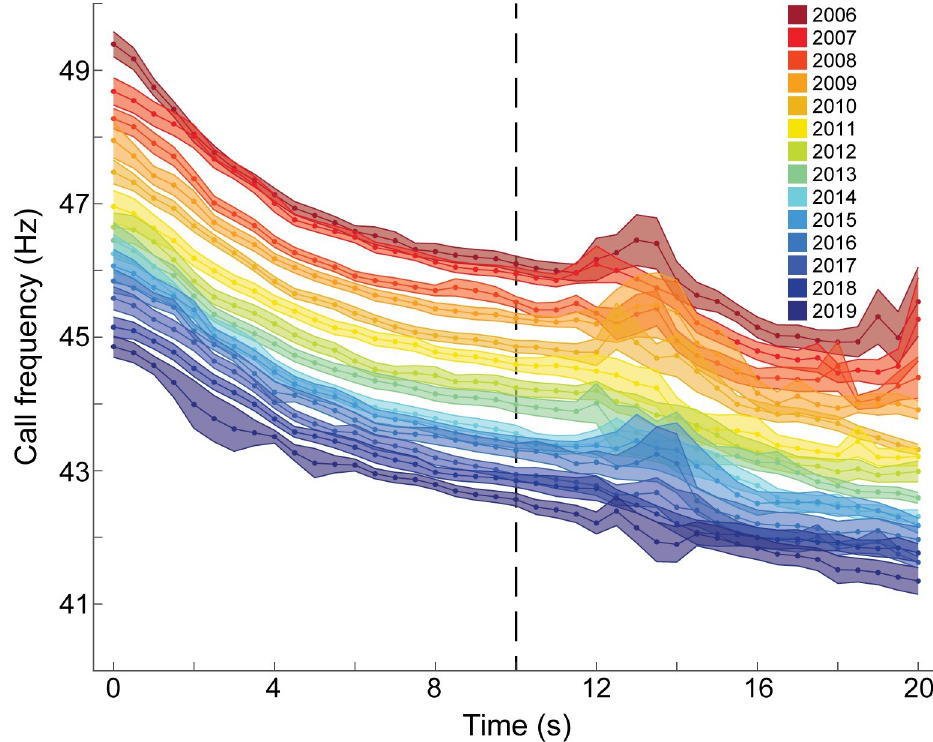
Fig 3. Mean frequencies of Northeast Pacific blue whale B calls. The first 20 s of the 3 rd harmonic are shown each year from 2006 to 2019. Shaded areas represent 95% confidence intervals and the dashed line indicates 10 s point that was used for yearly